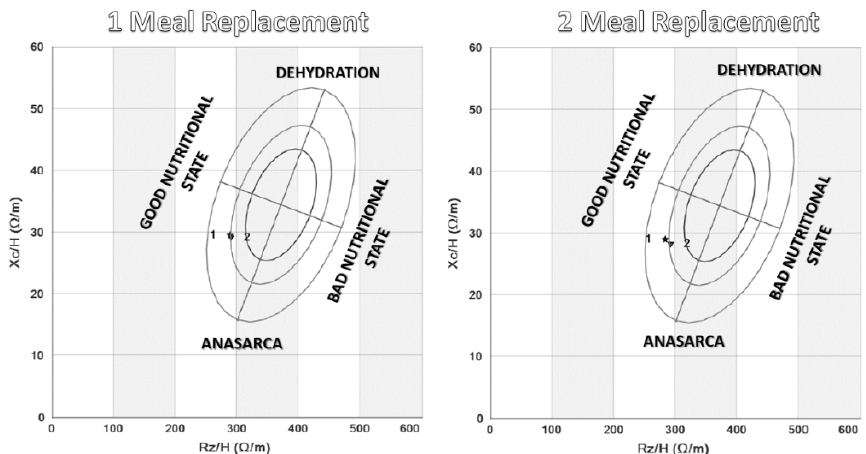
Figure 3. Changes in phase angle before (1) and three months after the intervention (2) in both randomized groups. The electrical parameters of resistance (Rz/H) and reactance (Xc/H) were directly assessed, and the alpha phase angle and impedance (Z) were estimated. Body composition was estimated, and vector impedance was assessed with Biva ® and Bodygram ® software (AKERN).